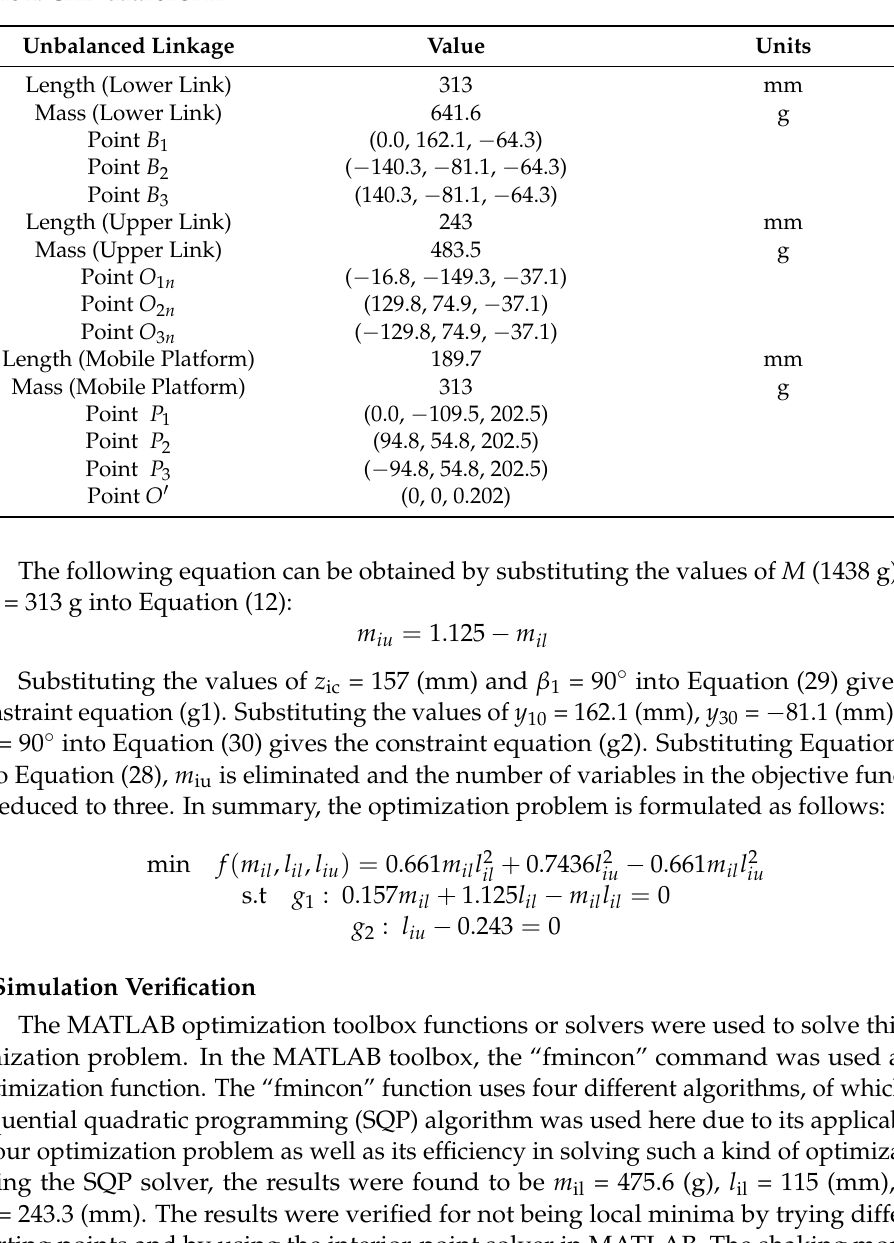
Table 2. CAD data of